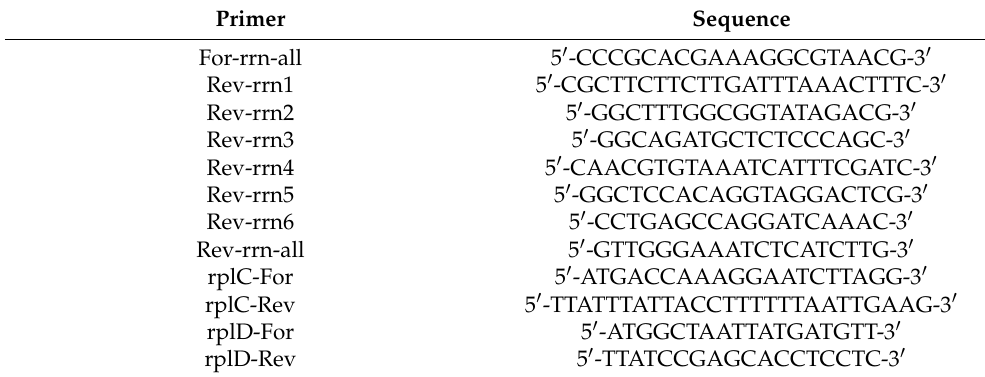
Table 1. Oligonucleotides used in PCR reactions.